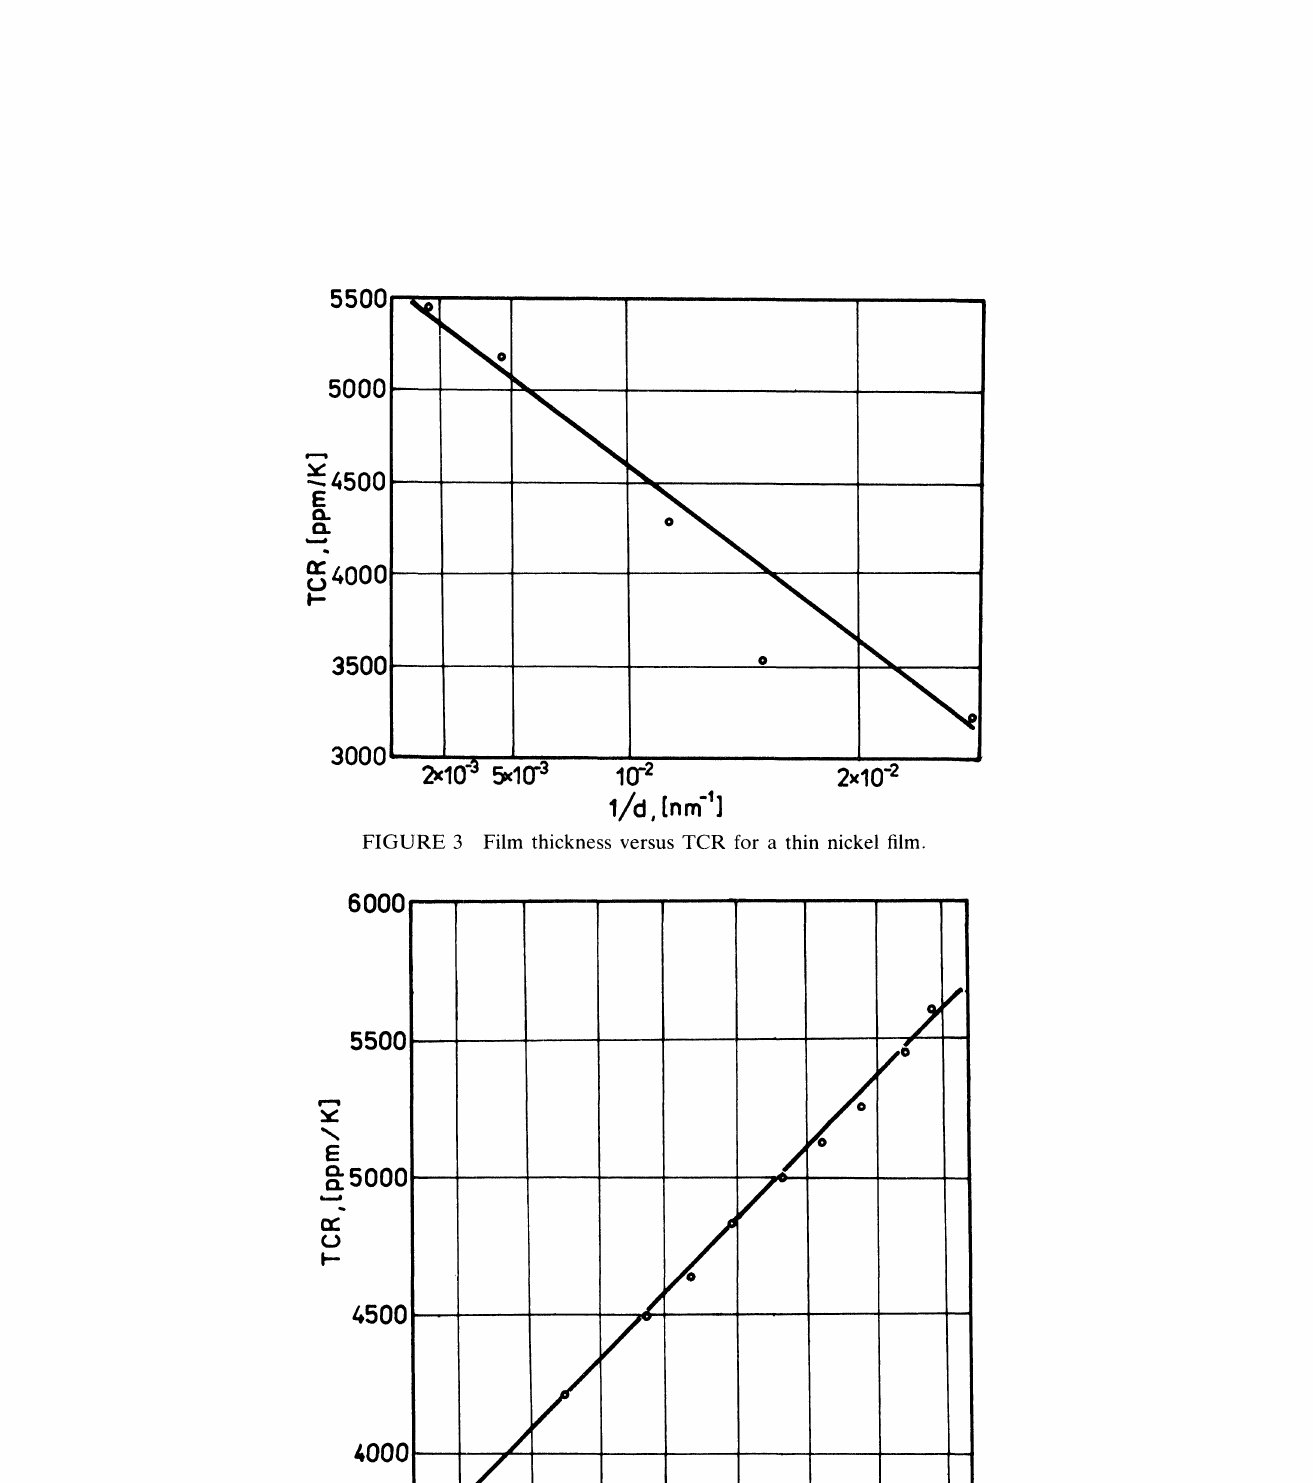
FIGURE 3 Film thickness versus TCR for a thin nickel film.